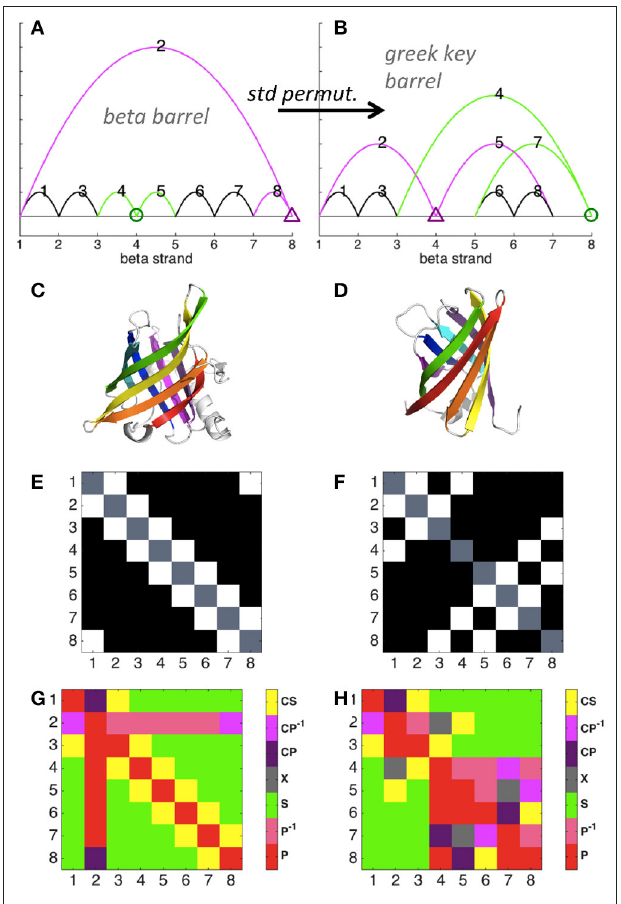
FIGURE 3 | Circuit diagram examples. Diagrams were calculated with distance cutoff 3.5 Angstroms and number cutoff 6 (see explanation in Figure S2 ). Maps were reduced such that each contacting site represents a node (1, 2, 3, 4, etc .) and non-bonded sites were excluded. (A) Beta barrel (pdb ID 1rbp) diagram. Sites and contacts involved in (4, 8) standard permutation are shown in green and magenta. (B) Greek key beta barrel (4cv7) diagram. (C) Beta barrel structure. (D) Greek key barrel structure. (E) Contact map of the beta barrel structure. Axes denote beta strand number, with contacts shown in white. (F) Contact map of the greek key barrel structure. (G) Relations between contacts of the beta barrel, numbered as shown in (A) . (H) Relations between contacts of the greek key barrel, numbered as shown in (B) .